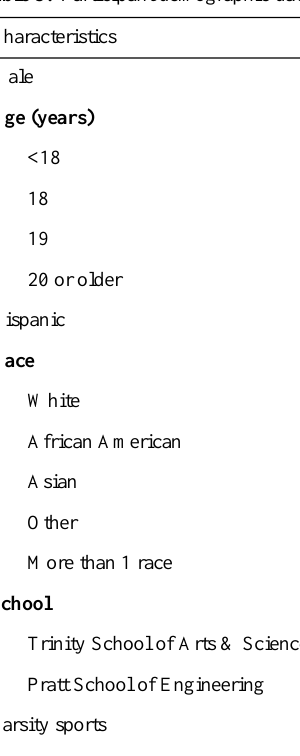
Table 3. Participant demographic data